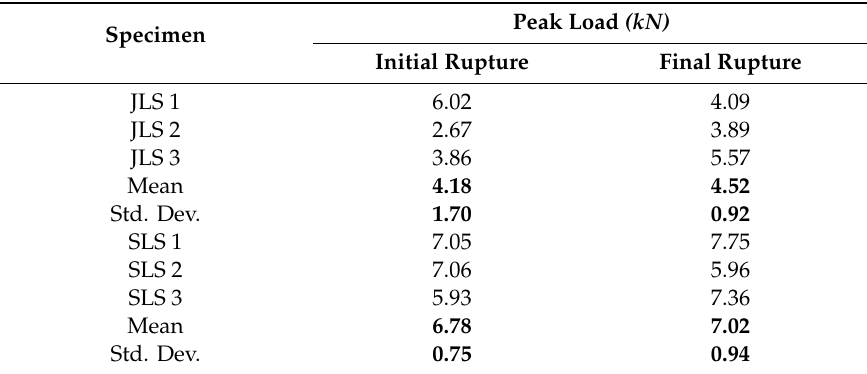
Table 3. Damage characteristics in JLS and SLS